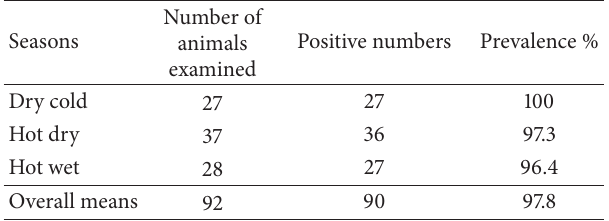
Table 1: Effect of season on the prevalence of donkey parasite